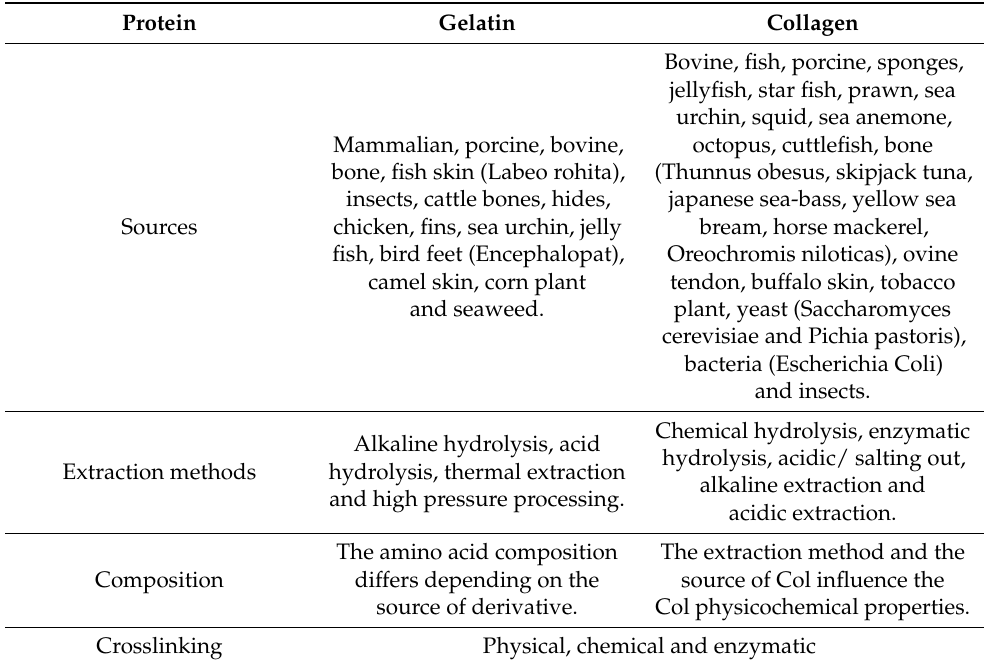
Table 2. Different sources of collagen and